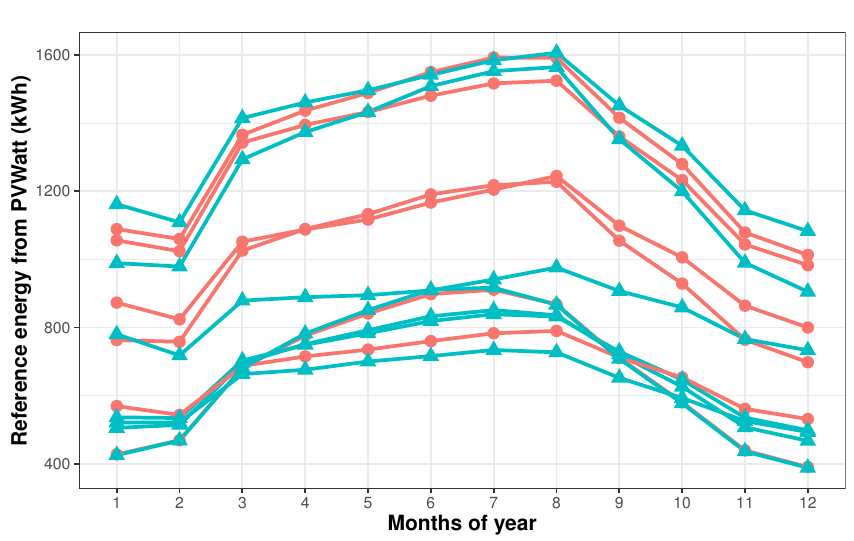
Figure 3. The referenced monthly energy of the DC optimizer and microinverter rooftop PV systems in Table 1 generated from the PVWatts tool